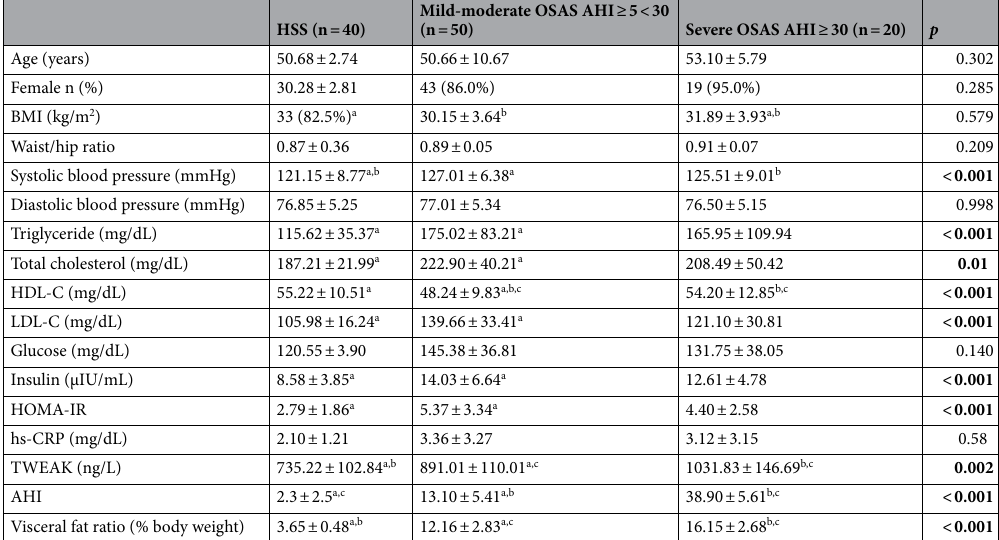
Table 1. Characteristics of patients with HSS, mild-moderate OSAS and severe OSAS. Significant values are in bold. HSS Habitual simple snoring. OSAS: Obstructive sleep apnoea syndrome. BMI: Body mass index, HDL-C High-density lipoprotein cholesterol, LDL-C Low-density lipoprotein cholesterol, HOMA-IR Homeostasis model of assessment-insulin resistance, LDL-C Low-density lipoprotein cholesterol, hs-CRP High sensitivity C-reactive protein, TWEAK Tumor necrosis factor (TNF)-like weak inducer of apoptosis, AHI Apnea/ hypopnea index. a Shows the difference between which groups. b Shows the difference between which groups. c Shows the difference between which